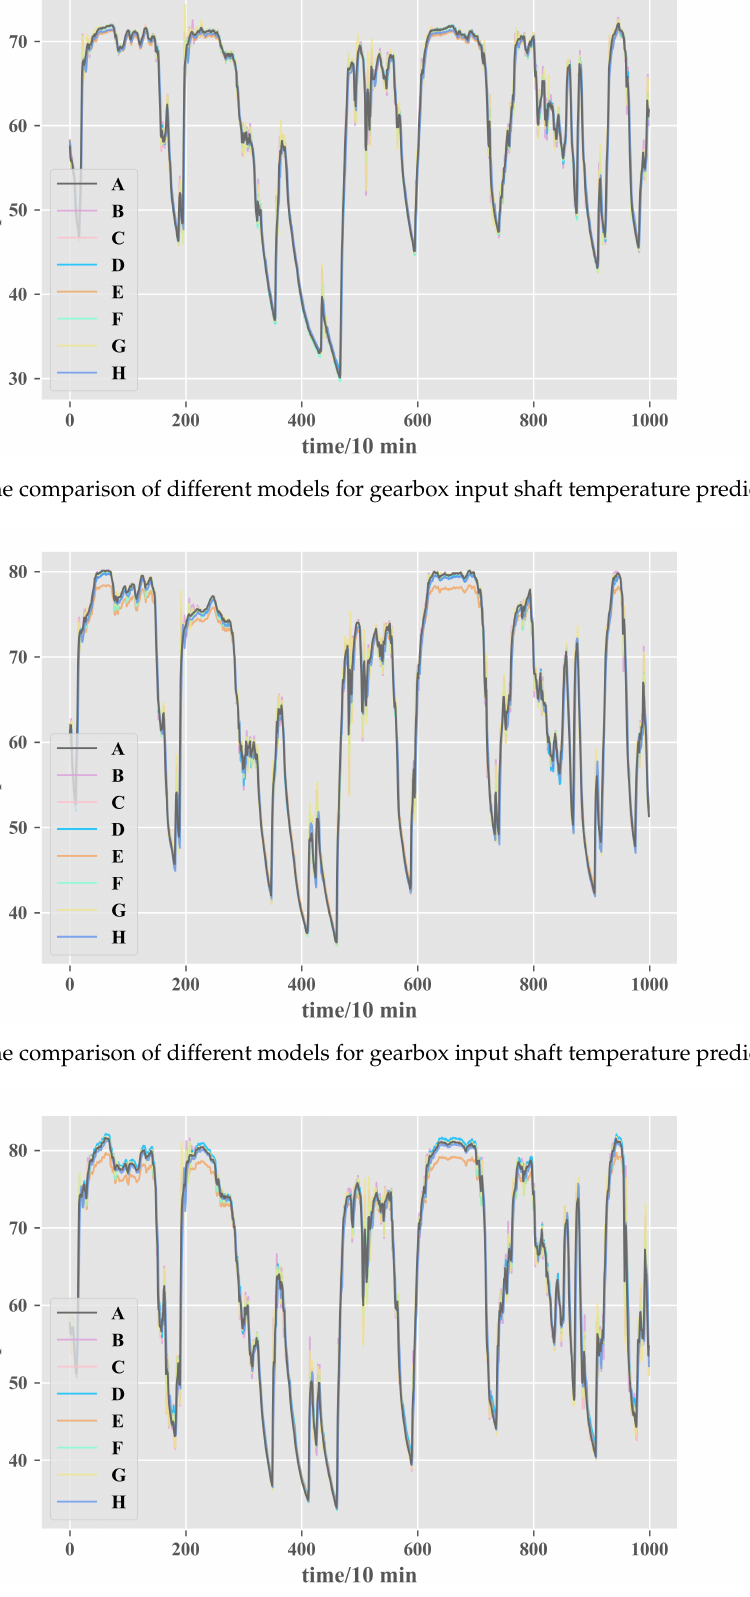
Figure 12. The comparison of different models for gearbox output shaft temperature prediction in